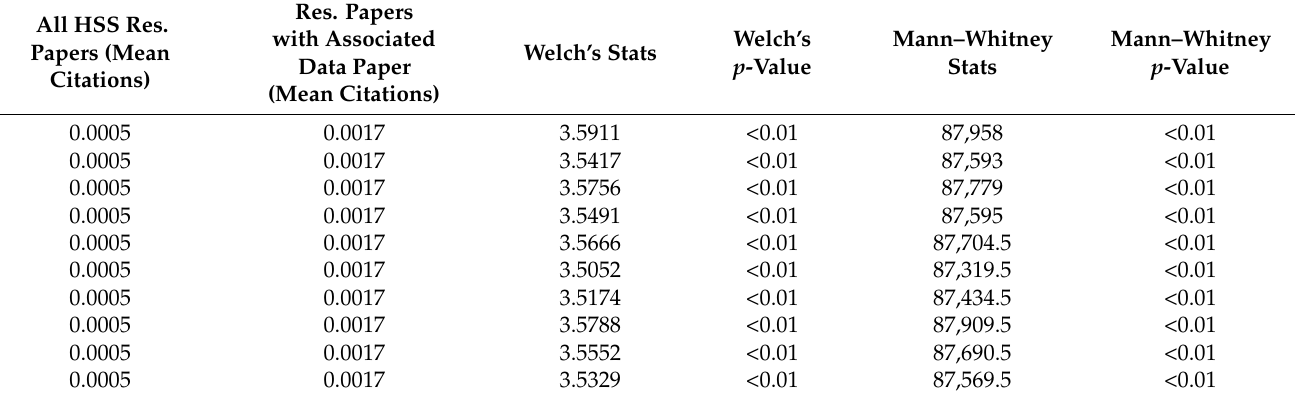
Table 6. Welch’s t -test and Mann–Whitney U -test results: mean citations of research papers with an associated data paper and all HSS research papers between 2015 and 2022, at each random sampling of the latter.